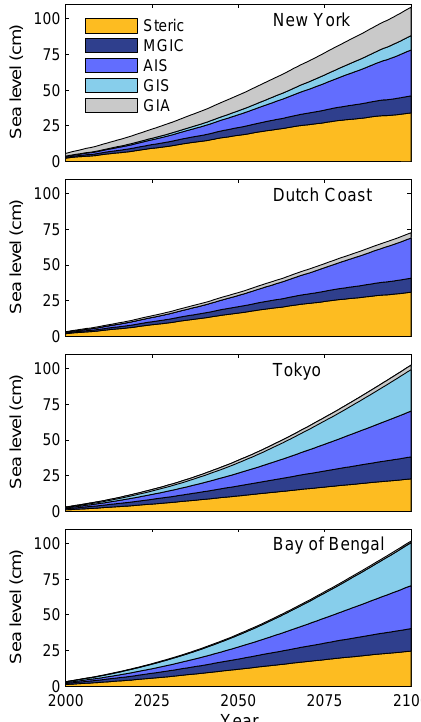
Fig. 11. Projected median contributions to sea level rise during the 21st century, around four coastal locations for the semi-empirical case, under the RCP 4.5 scenario. Each colour represents a contribu- tion to sea level rise. In this example, the glacial isostatic adjustment (GIA) contribution (based on ICE-5G, VM2) has been included for comparison with the other